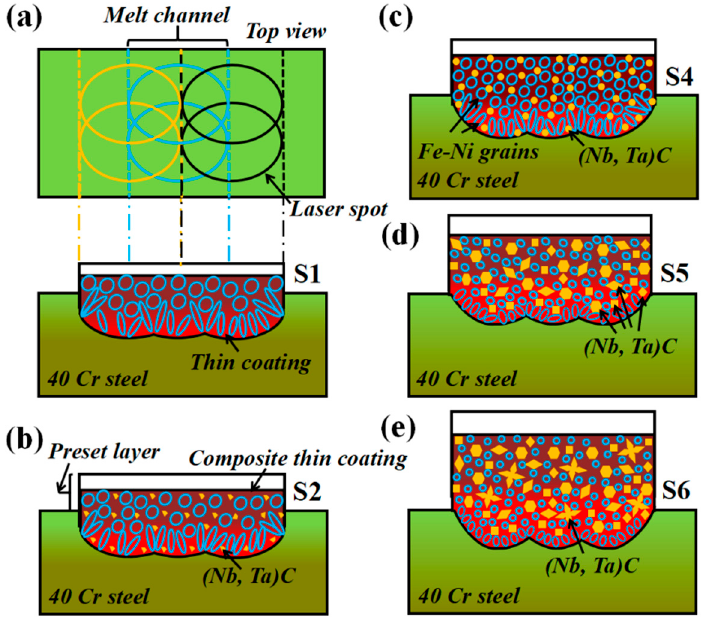
Figure 8. Schematic diagrams of cross-sectional structure change and heat dissipation of composite coating with different ceramic micro-particles. ( a ) S1; ( b ) S2; ( c ) S4; ( d ) S5; ( e )